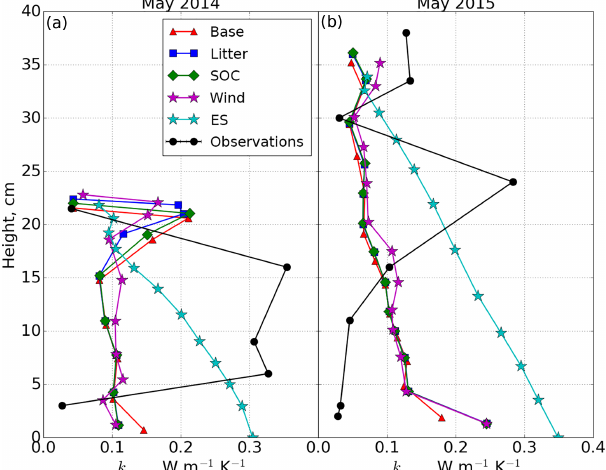
Figure 5. Measured and simulated snow thermal conductivity val- ues as a function of density. Crocus computes k snow from the den- sity only following Yen’s parameterization, while ES includes the thermal effects of latent heat fluxes within the snowpack. Regres- sion curves from Yen (1981) and Sturm et al. (1997) are also shown as well as observed snow